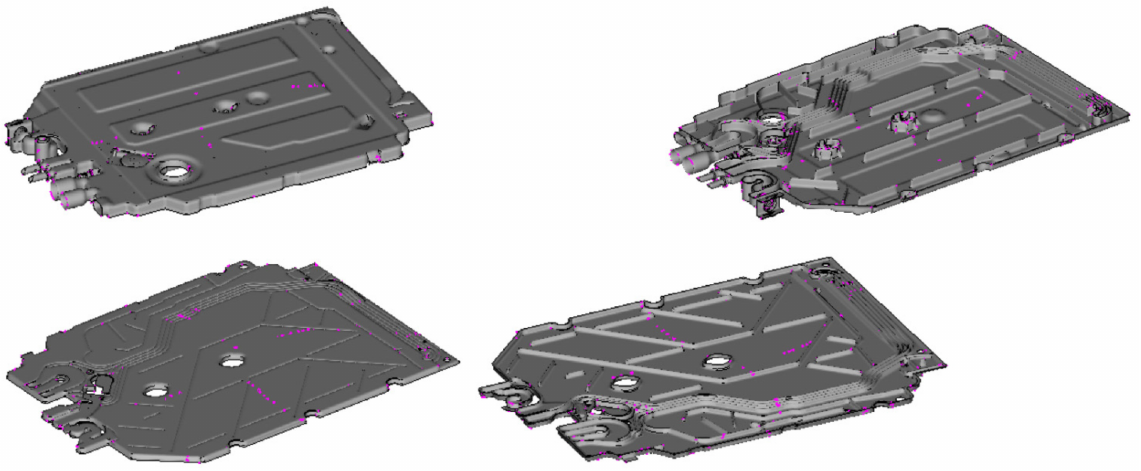
Figure 18. The so-called siphons. Shear rate measures how quickly layers of plastic slide past each other. If this happens too quickly, the polymer chains can break, and the material degrades. The higher shear rate should not exceed the maximum value recommended by the material supplier, and exceeding this value is likely to lead to polymer degradation. It is a good rule not to exceed 60% of the value recommended by the supplier for aesthetic applications. In the analysis below (Figure 19), you can see a slight difference in the shear rate.